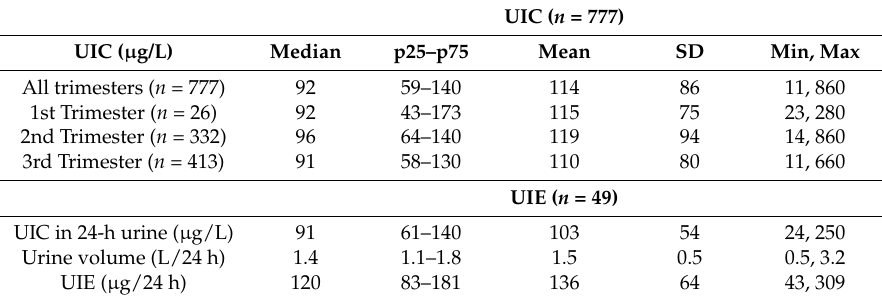
Table 2. Urinary iodine concentration (UIC) by trimester in spot samples ( n = 777) a , and UIC, urine volume and urinary iodine excretion (UIE) in 24 h urine samples in the sub-study ( n = 49).